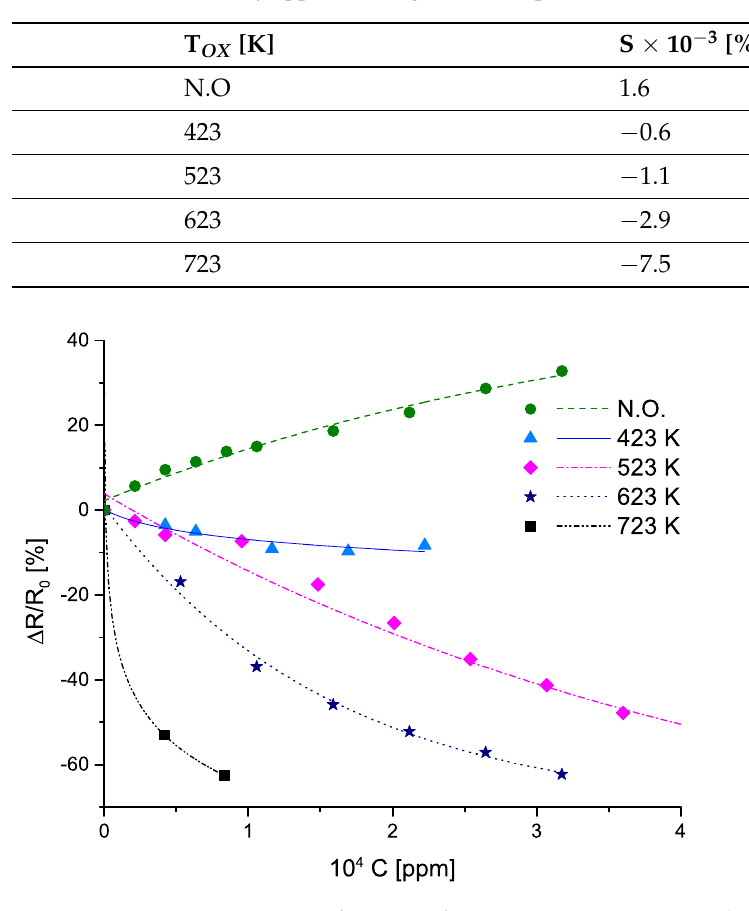
Figure 7. Sensor response as a function of IPA concentration. Legend shows thermal oxidation temperature of the samples. Data were fitted with exponential function. The error bars are at most in the order of the symbol size.